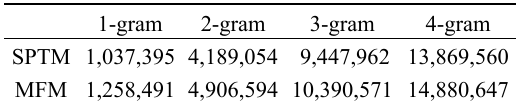
Table 1. Dimensions of k -gram Feature Vector Space under the Two Representations: SPTM and MFM.